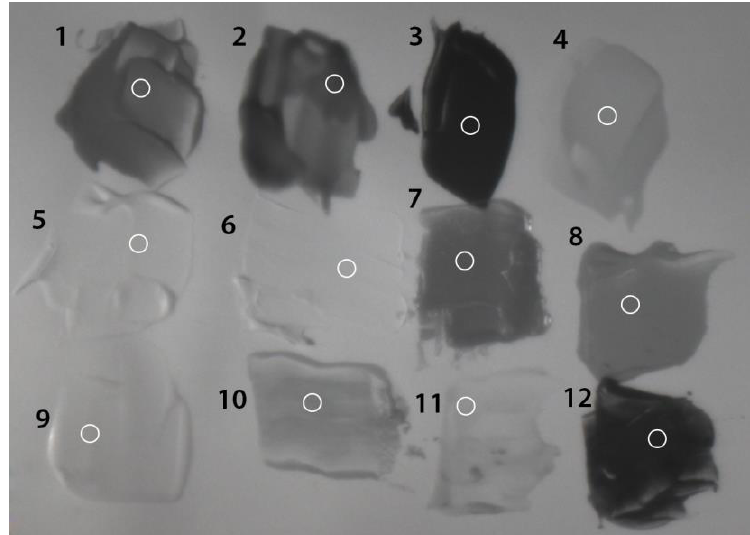
Figure 3. Light blocking at 850 nm. Table 1. ACR11 dyes (1–12), λ max, Lab V, Lab 735, Lab 850, Z (735)750, Z 850, Z 900.